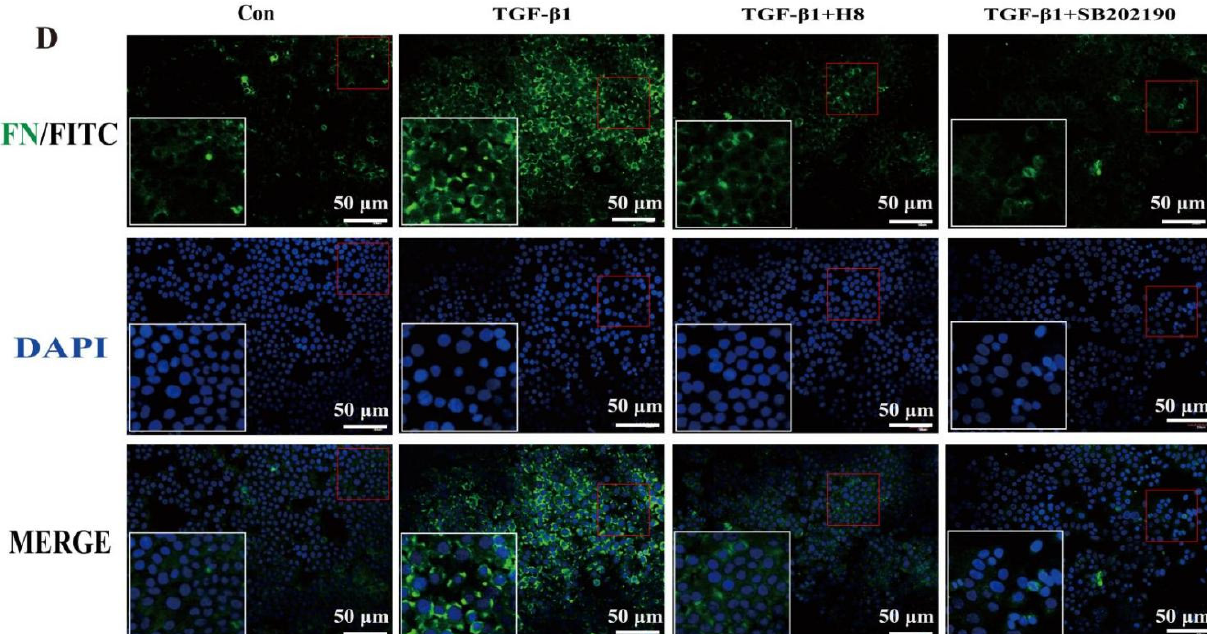
Figure 3. H8 attenuated the over-deposition of ECM and inhibited p38MAPK in the TGF- β 1-induced HK-2 cells. ( A ) The mRNA expression levels were examined by qPCR, and the values were normalized to rps16 ( α -SMA, TGF- β 1, FN, Col IV, and E-Ca). ( B ) Western blot band. ( C ) The protein relative expression levels (a-SMA, TGF- β 1, FN, Col IV, E-Ca, and the ratio of P-p38MAPK/p38MAPK). ( D ) The IF was performed using FN antibody, and DAPI was used for staining cell nuclei (scale bar = 50 μ m). Data are shown as mean ± S.D. ( n = 5). ### p < 0.001 compared to Con group; * p < 0.05, ** p < 0.01, and *** p < 0.001 compared to TGF- β 1 group; n.s. represents no significant difference in statistics.